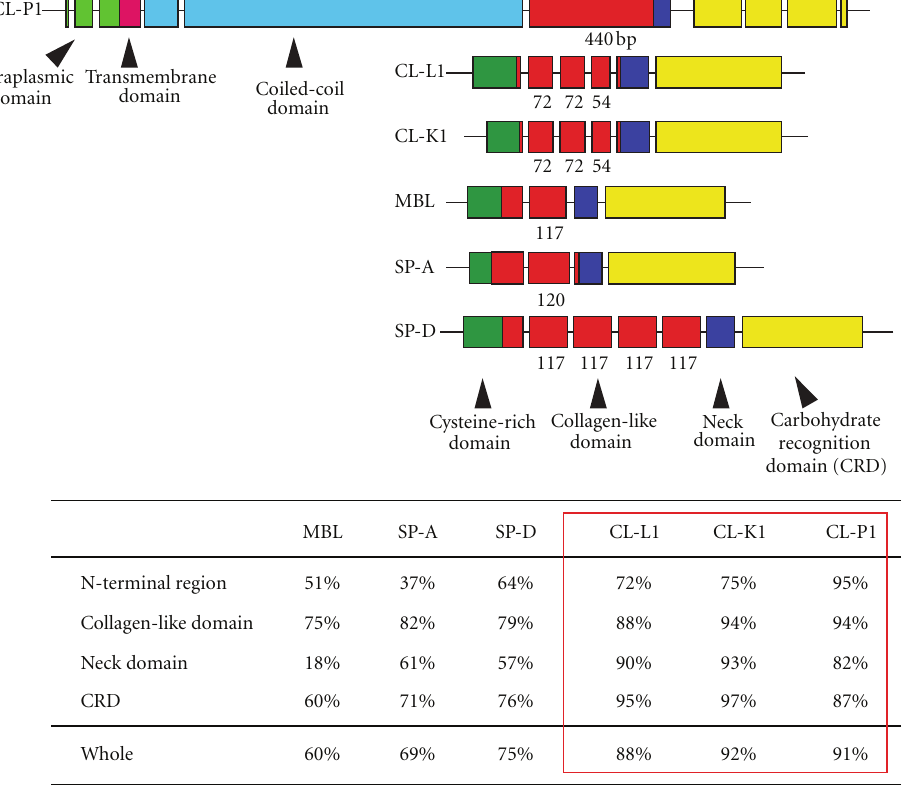
Figure 1: The gene organization of human collectins and a comparison of the rates of the homology among the individual domains of human and murine collectins. In the gene organization schematic, the domain structure can be seen to consist of an intraplasmic domain, a transmembrane domain, a coiled-coil domain, a cysteine-rich domain, a collagenous domain, a neck domain, and a CRD. Collectin components are listed in the table as the N-terminal region, a collagen-like domain, a neck domain, a CRD, and the whole